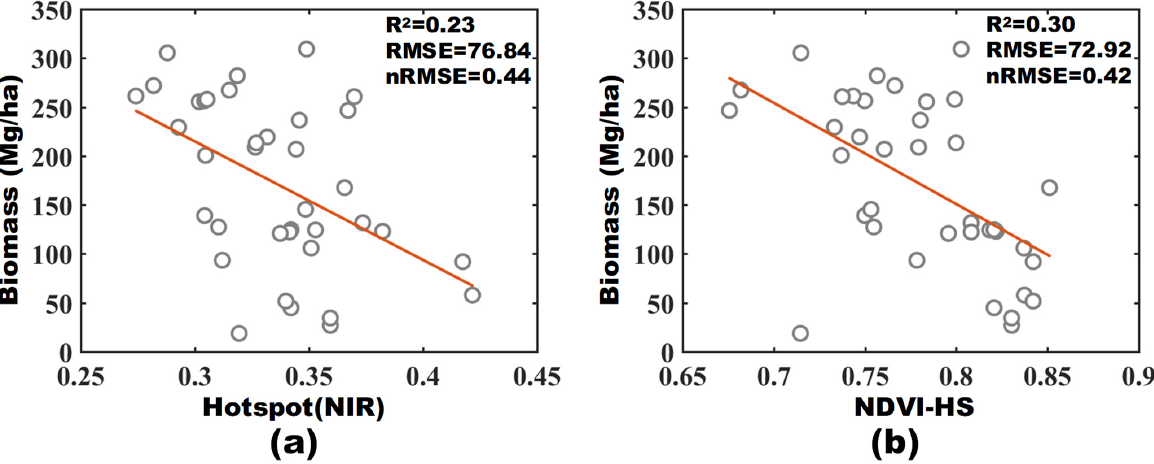
Figure 10. Linear regression results of using ( a ) MODIS hotspot reflectance of NIR band to estimate forest AGB, of which the MODIS BRDF data obtained in winter and ( b ) BRDF shape indicator (NDVI-HS) to estimate forest AGB, of which MODIS BRDF data also obtained in